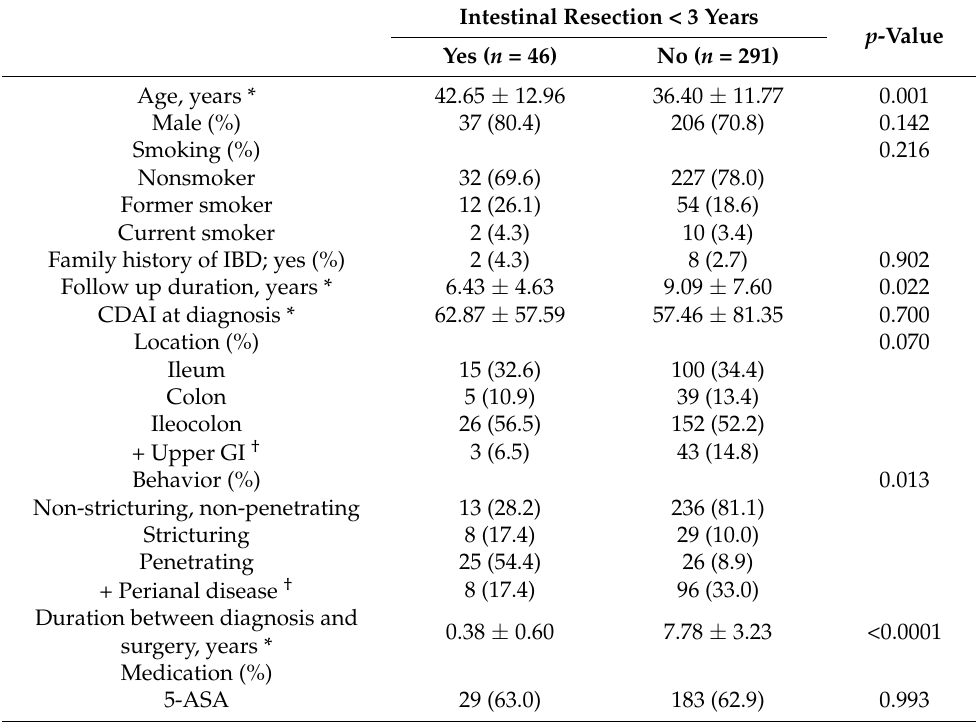
Table 1. Baseline characteristics of the study